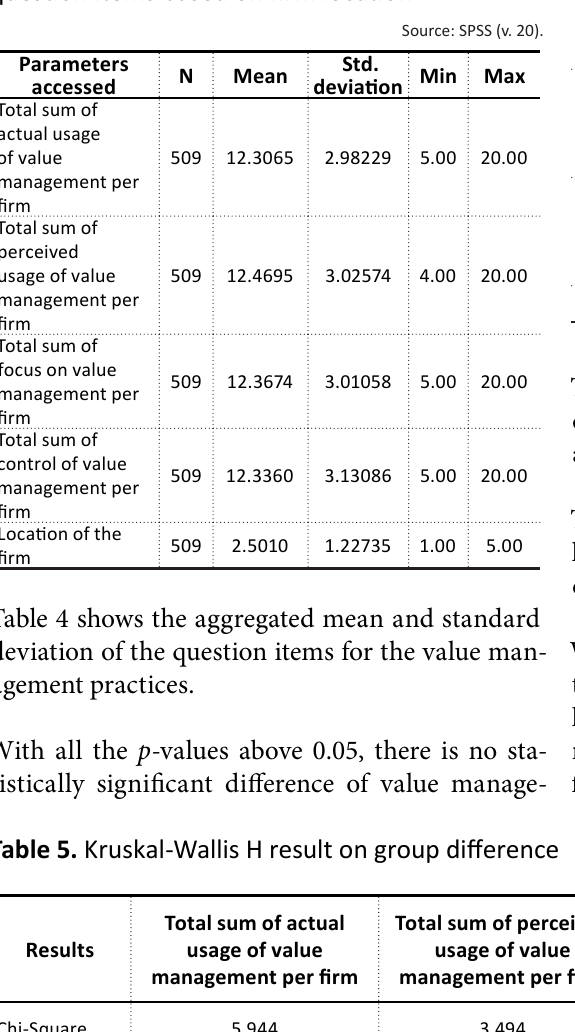
Table 4. Descriptive statistics on the collation of